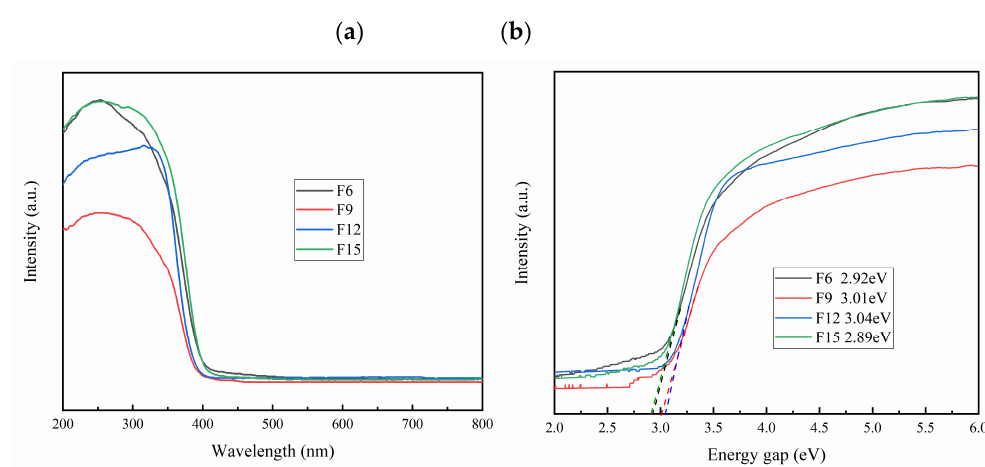
Figure 6. Uv-vis absorption diagram ( a ), band gap ( b ) of the samples